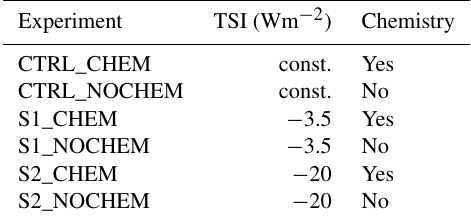
Table 1. Overview of the ensemble experiments used in this study. Each ensemble consists of 10